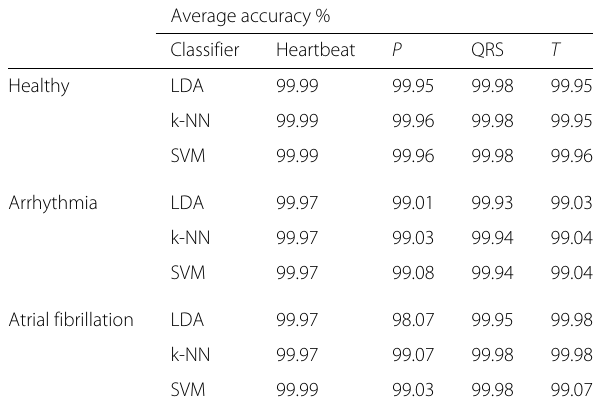
Table 2 ECG window by the method proposed in 5 different cases